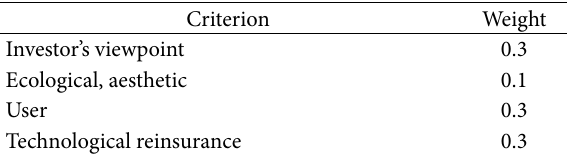
Table 2. Evaluating criteria of the 1 st degree